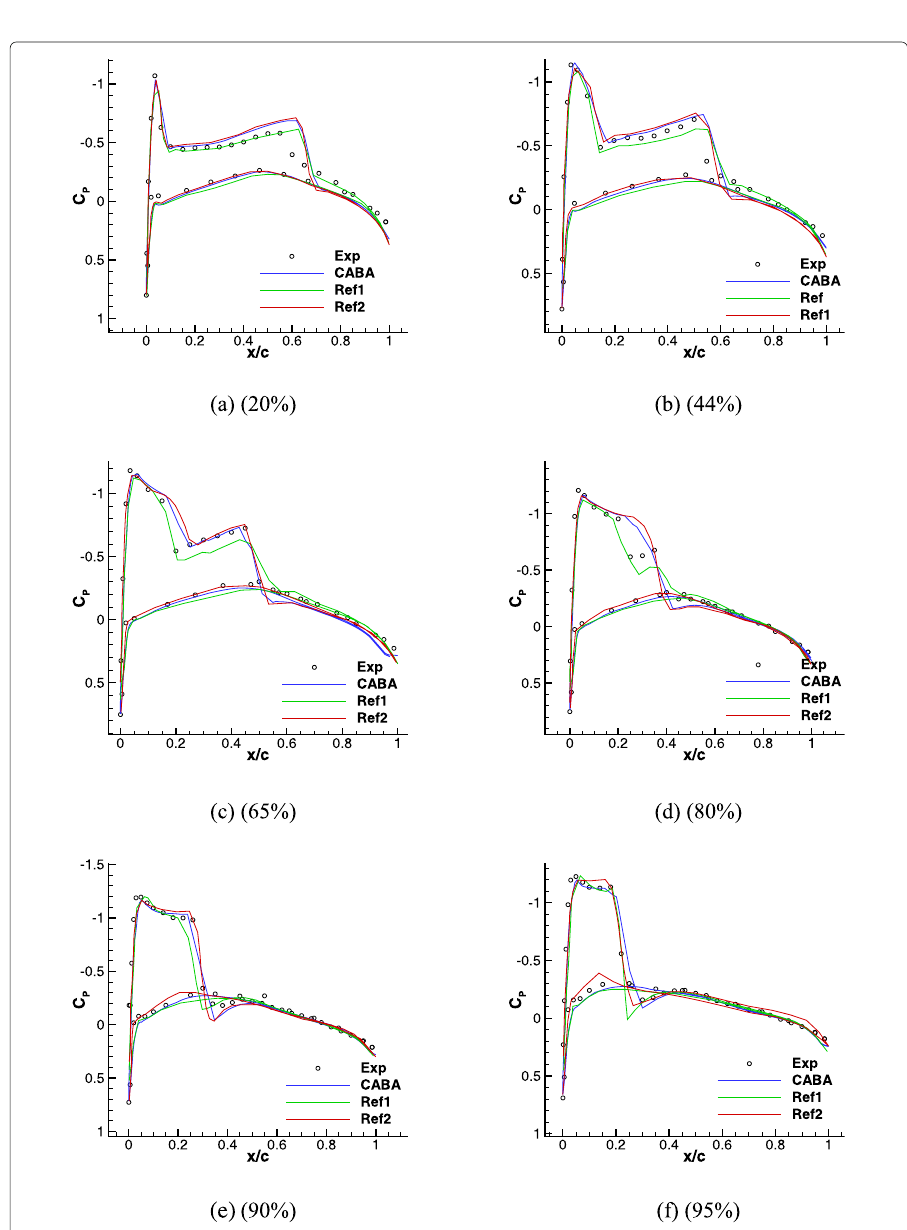
Fig. 24 Pressure coefficient distributions on the different spanwise sections of ONERA M6 wing